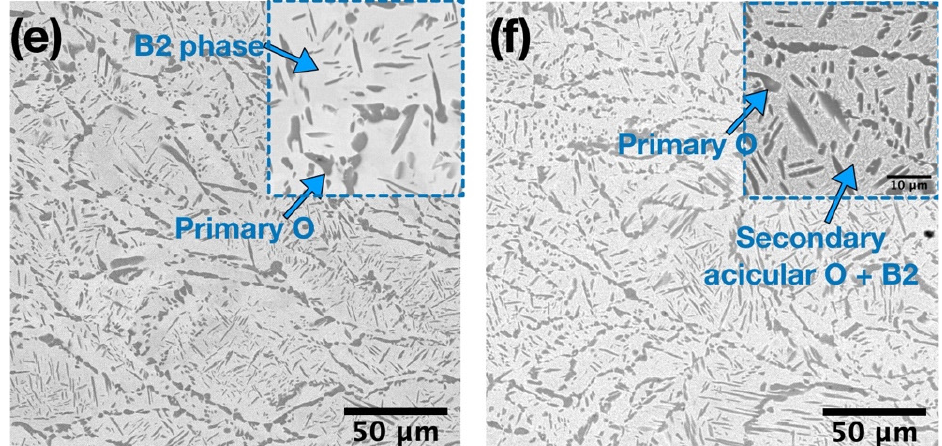
Figure 12. Microstructures of the as-fabricated samples after heat treatment: ( a ) SA followed by FC, ( b ) SA followed by FC plus aging. Microstructures of the HIPed samples after heat treatment: ( c ) SA followed by FC, ( d ) SA followed by FC plus aging, ( e ) SA followed by WC, ( f ) SA followed by WC plus aging. Insets show microstructures of the corresponding samples at higher magnifications.